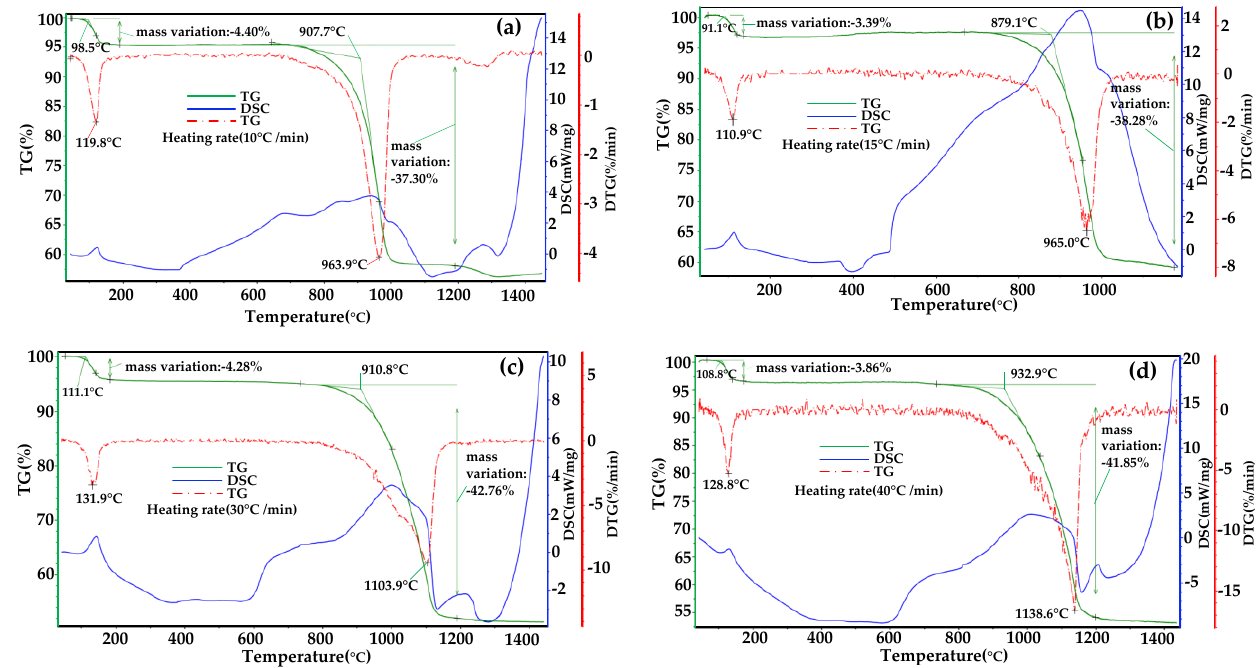
Figure 10. Analysis of decomposition heat of phosphogypsum at different temperature rising rates: ( a ) 10 °C/min; ( b ) 15 °C/min ; ( c ) 30 °C/min; ( d ) 45 °C/min.